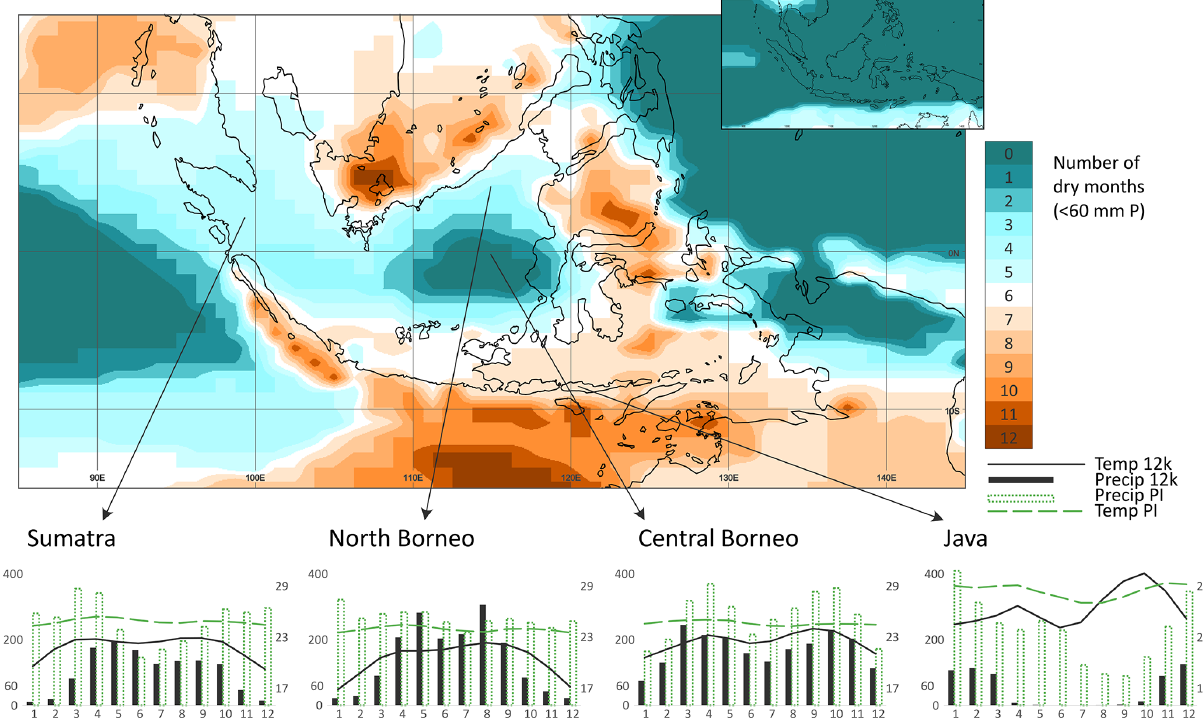
Figure 4. Number of simulated dry months per year at 12kaBP and comparison of the regional annual temperature and precipitation cycles for 12kaBP and PI. The inset shows the number of dry months ( < 60mm P /month) per year for PI. Climate diagrams show the monthly average temperature and precipitation from PI (green) and 12kaBP (black) based on CESM1 simulations. Sumatra, Java and North Borneo locations approximately correspond to speleothem cave locations from the reconstructions in Fig.